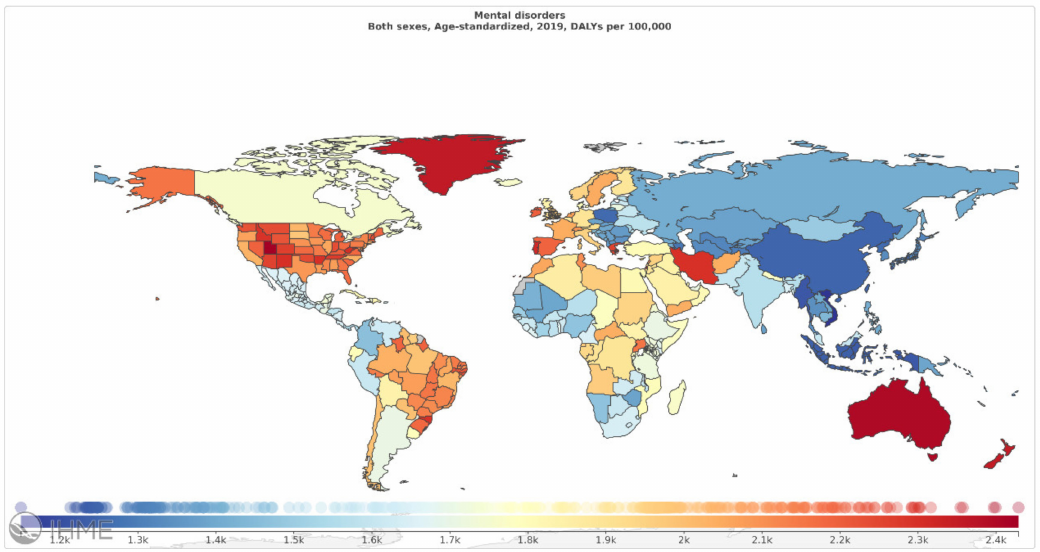
Figure 2. Mental disorders, age-standardized DALY rates (per 100 000) by location, both sexes combined, 2019 (reproduced with permission from